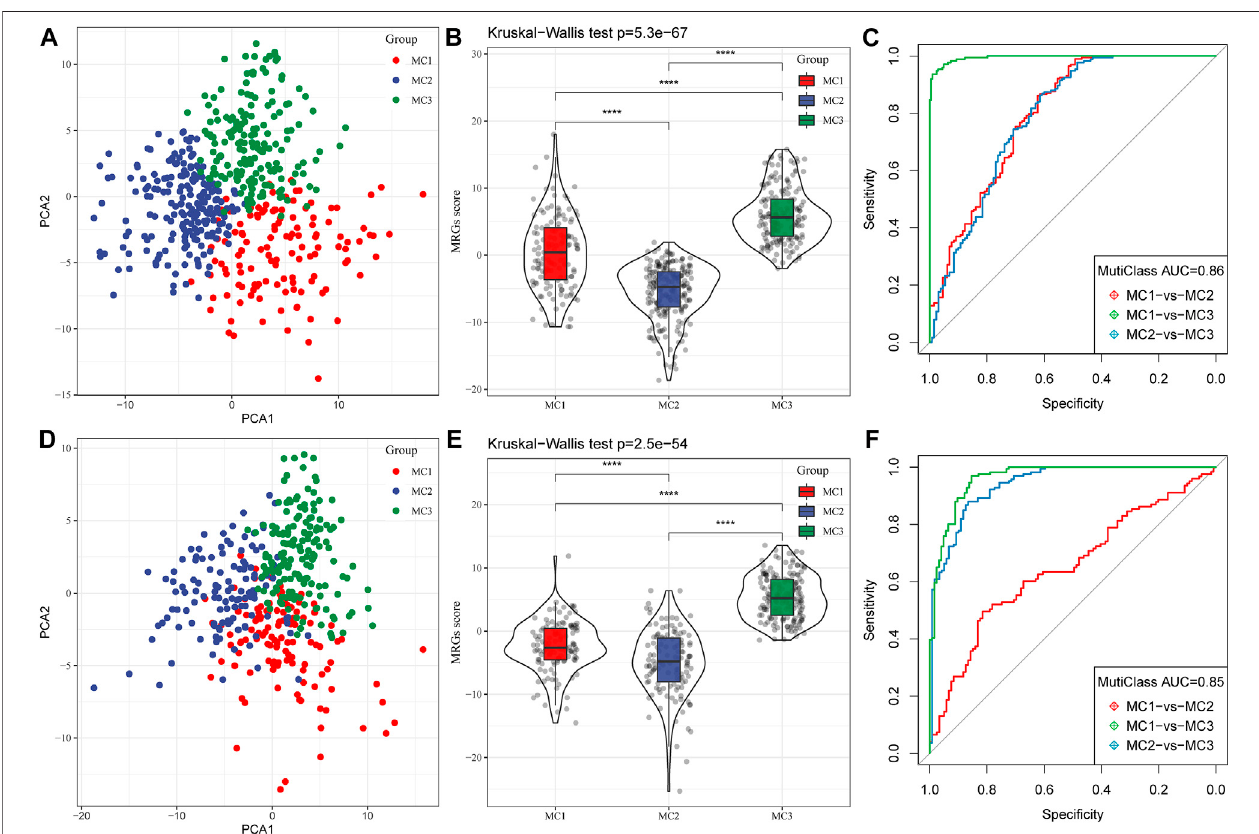
FIGURE 5 | Construction of metabolic subtype characteristic score. (A) The relationship between two key metabolic signatures and metabolic subtypes in the TCGA cohort. (B) The metabolic subtype signature scores of different subtypes in the TCGA cohort. (C) The ROC curve for metabolic subtype signature scores in the TCGA cohort. (D) The relationship between two key metabolic signatures and metabolic subtypes in the CGGA cohort. (E) The metabolic subtype signature scores between different subtypes in the CGGA cohort. (F) The ROC curve for metabolic subtype signature scores in the CGGA cohort.